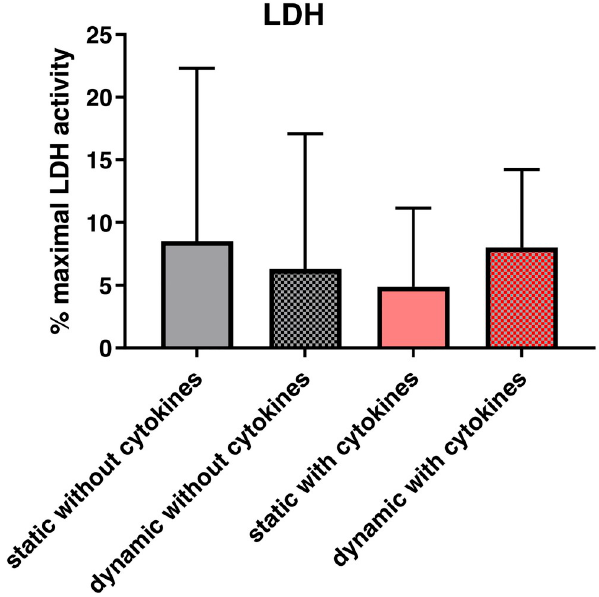
Fig 2. Effect of vibration and/or cytokine treatment on cell viability and gene expression. After 72 hours of exposure to a vibration pattern and/or cytokine treatment and an additional one-hour rest period, supernatants were collected for LDH activity assay. The LDH activity was expressed as percentage of the maximal LDH activity. p < 0.05 was considered significant.